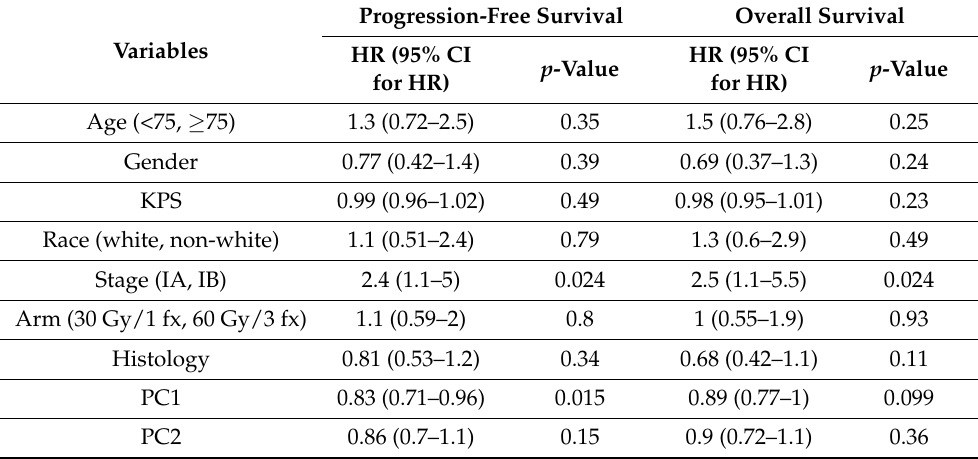
Table 3. Univariate Cox regression